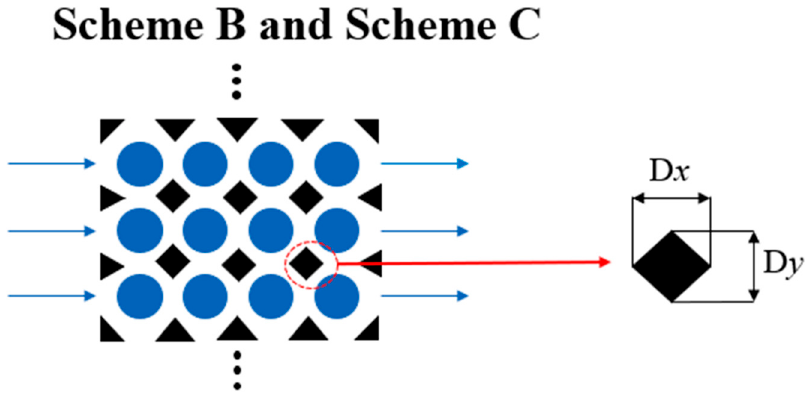
Figure 1. Benchmark scheme (scheme A) and computational domain.